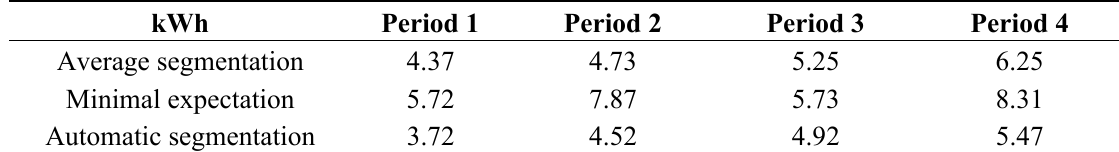
Table 5. Maximal energy needed with the three methods.